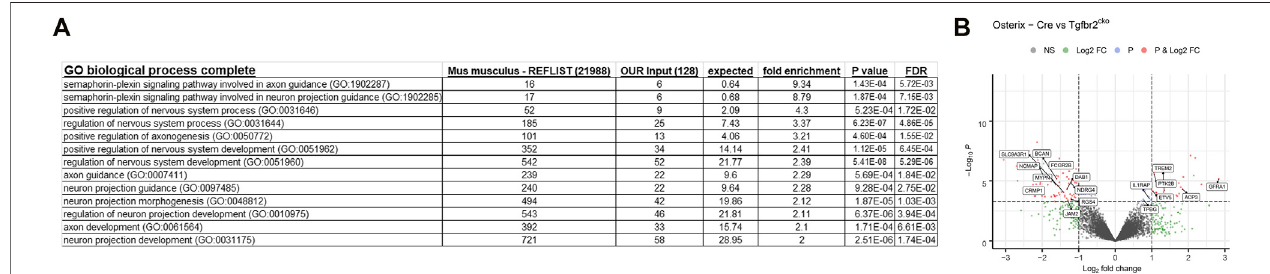
FIGURE 5 | Panther gene ontology analyses identify several transcriptomic categories related to axon guidance that differ between the Osterix-Cre and Tgfbr2 cko mice. (A) SeveralGObiologicalcompletecategorieswereidenti fi edasbeingover-representedbasedonthetranscriptomesthatweredysregulatedby ≥ 1.5-foldwith p < 0.05 in Tgfbr2 cko mice, as identi fi ed by RNA-Seq. The Panther gene ontology analysis was performed using the Panther GO biological process complete for overrepresentedgeneswithaFisher ’ sexacttest. (B) AVolcanoplotoftheRNA-Seqdatademonstratingsigni fi cantdifferencesbetweenOsterix-Creand Tgfbr2 cko samples and select overrepresented neuronal genes reported by Panther in the categories shown in (A)